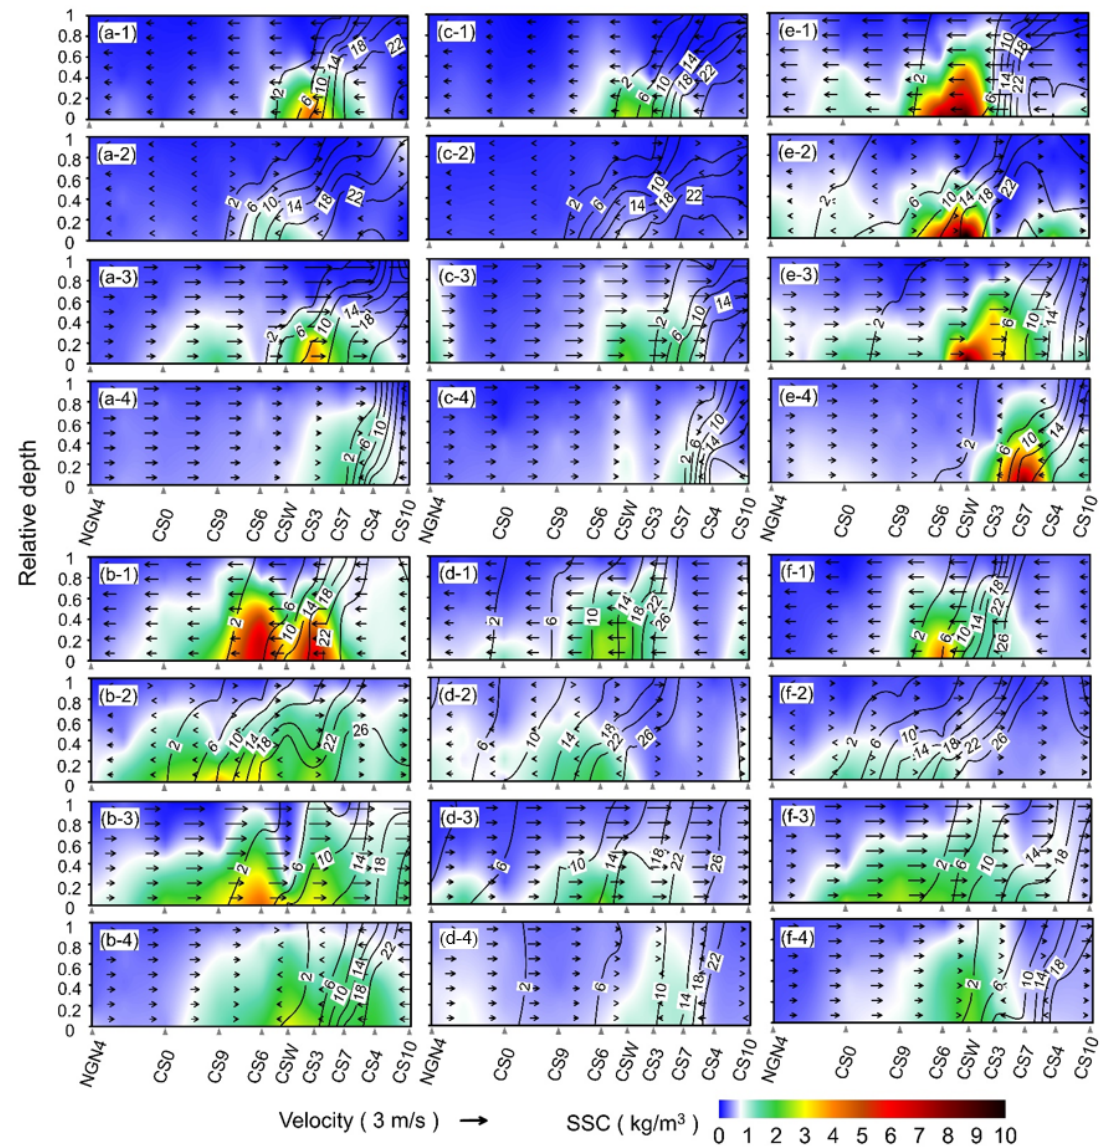
Figure 4. Variations of axial current, salinity and SSC along the DNC: The a – f represent six observations, respectively (according to Figure 2). 1 – 4 represent peak flood, high water slack, peak ebb and low water, slack respectively. The rightward arrow means seaward axial current, and the leftward arrow means landward axial current. The isohalines (in psu) are shown in black lines.